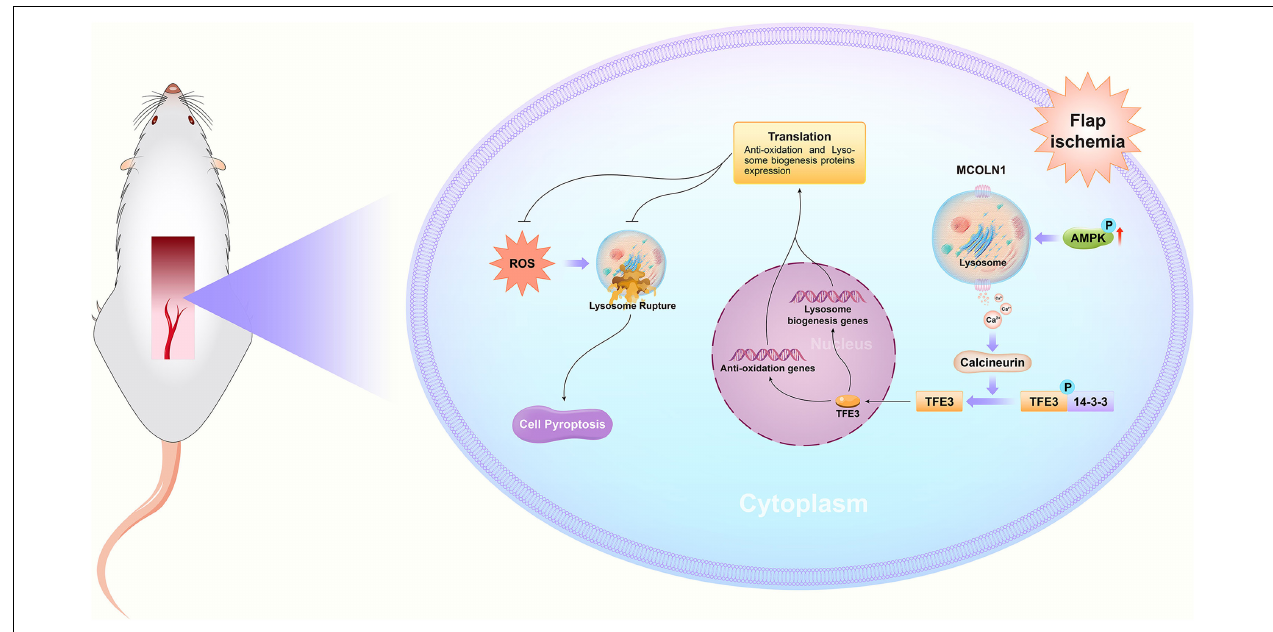
FIGURE 8 | Schematic diagrams emphasizing the pathophysiological molecular mechanisms of TFE3, ROS, and pyroptosis in the necrosis of skin